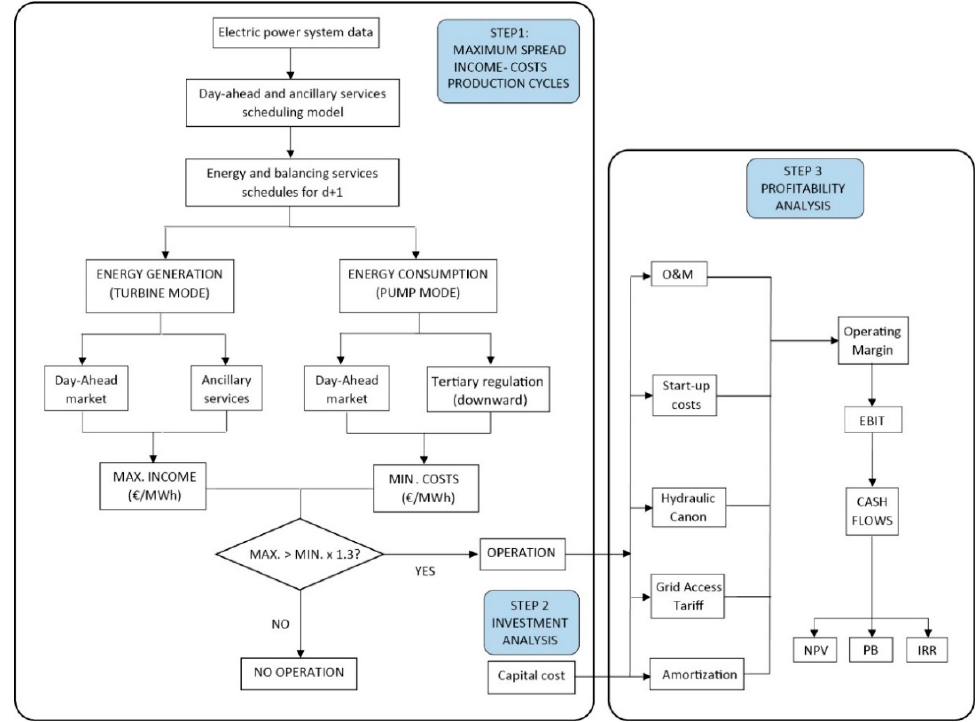
Figure 1. Methodology scheme to analyze the economic feasibility of underground pumped storage hydropower (UPSH) plants.